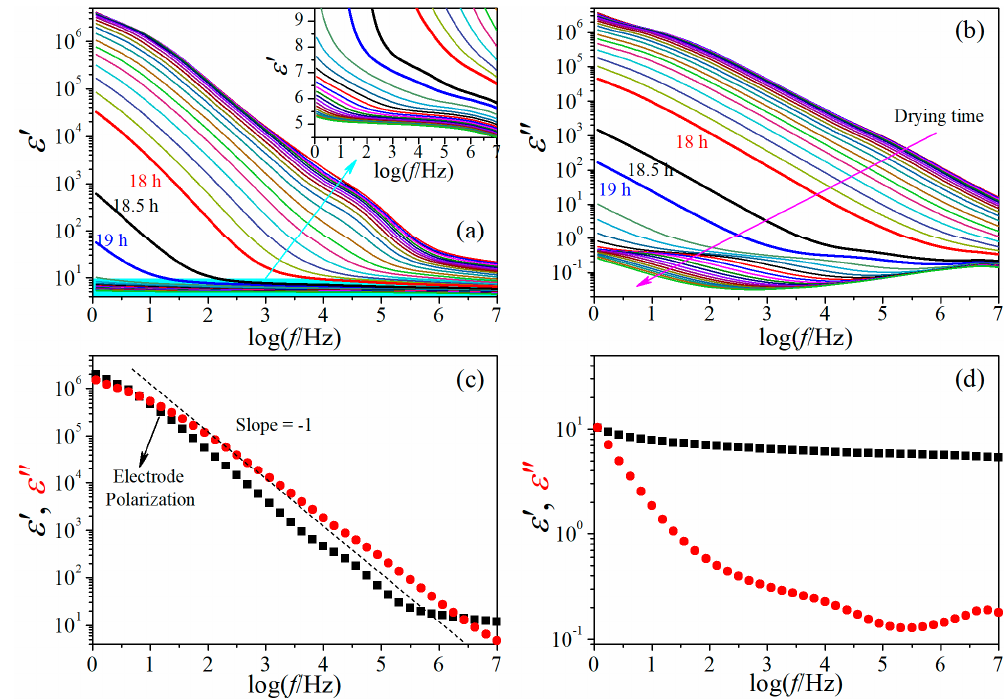
Figure 1. Variation of ( a ) dielectric constant and ( b ) dielectric loss of regenerated cellulose film with time during drying at 20 ◦ C. The inset in ( a ) is the enlargement of dielectric constant spectra of the film after 19 h drying. Representative dielectric spectra at drying time of 10 h ( c ) and 22 h ( d ). The dashed line with a slope of − 1 in ( c ) indicates dc conductivity.